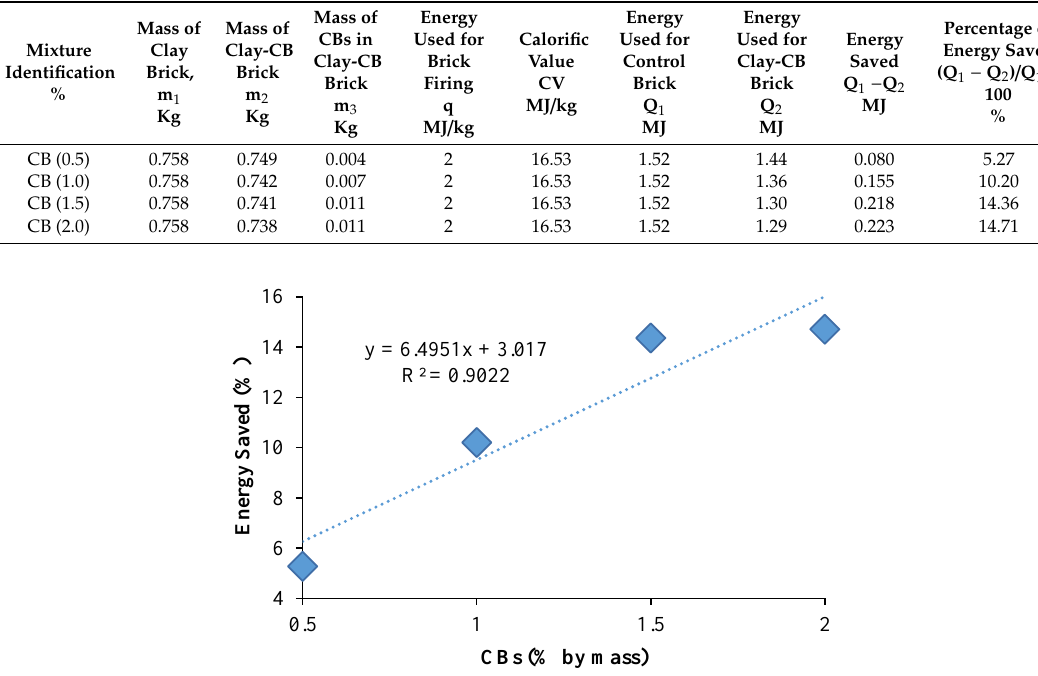
Table 2. Calculated value of energy saved during the firing of brick samples.